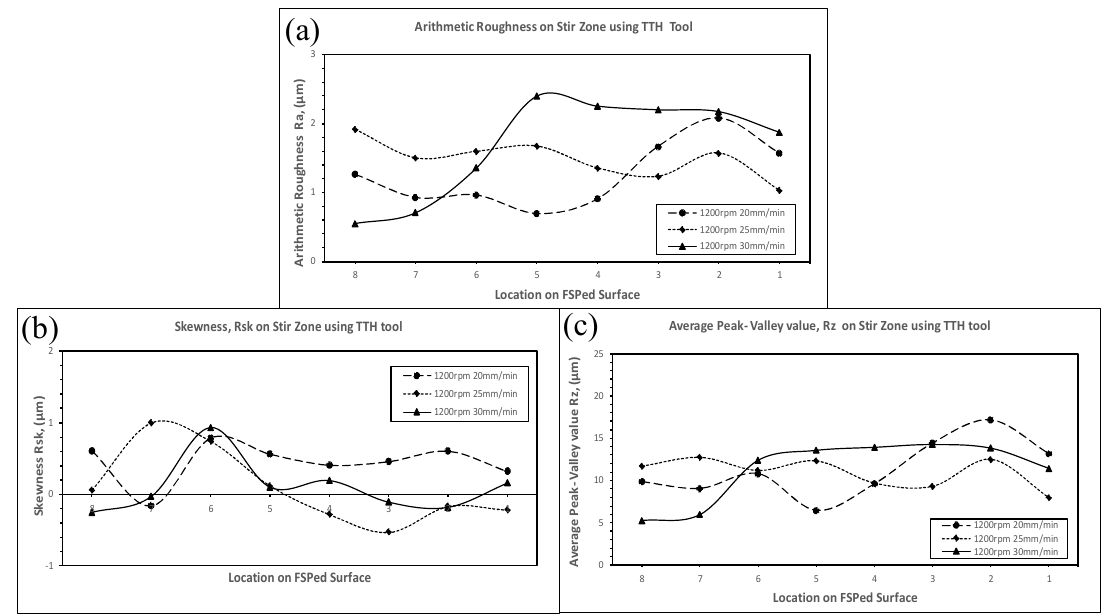
Figure 10. ( a ) Arithmetic roughness, Ra, ( b ) skewness, Rsk, and ( c ) average peak-valley, Rz, value for FSP using 1200 rpm and TTH tool at different feed rates.